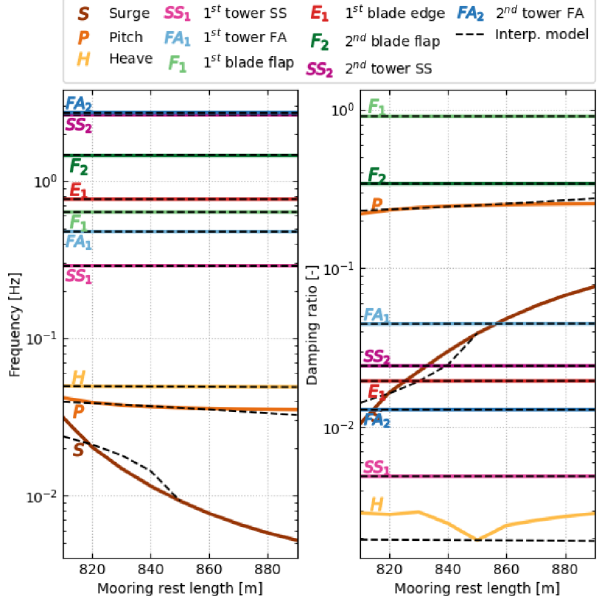
Figure 6. Variation of the system damped frequencies and damping ratios as a function of the mooring line unstretched length evaluated using the direct method (plain lines) and the interpolation method (dashed